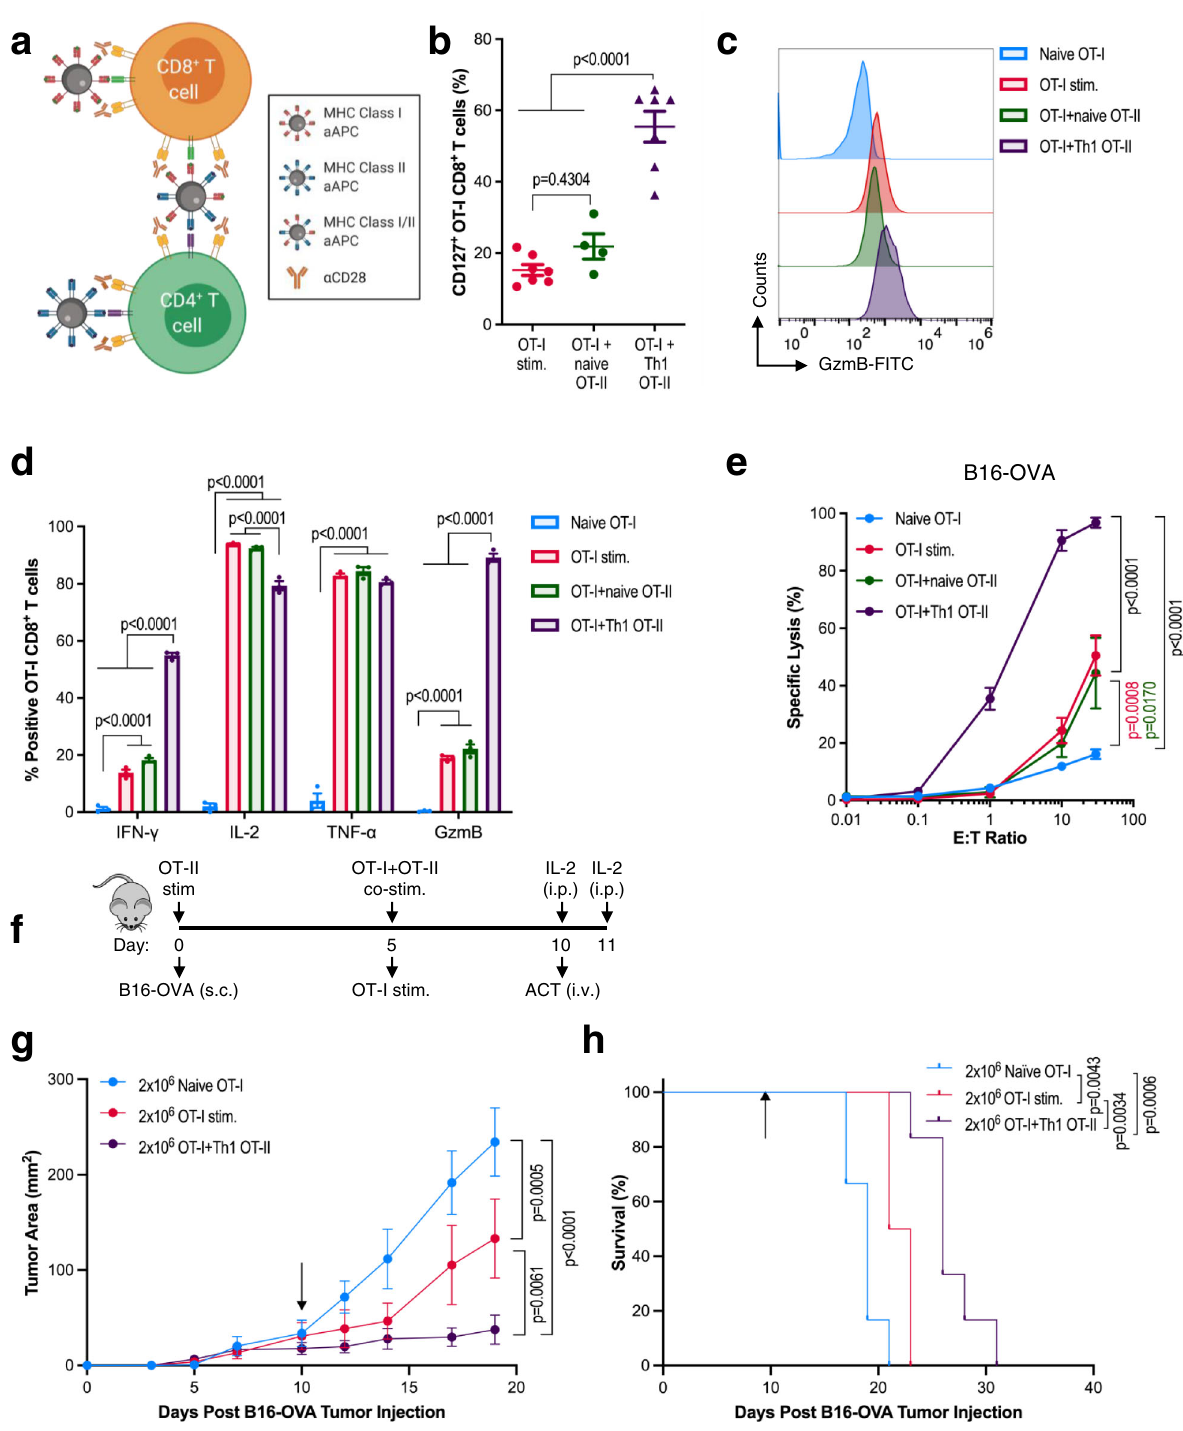
Fig.4|MHCIIaAPCsmodulateCD4 + Tcellhelperfunction.a Schematicshowing separate (I+II) or joint presentation (I/II) of MHC I and MHC II on aAPCs to CD4 + and CD8 + T cells to facilitate cell-cell crosstalk. Created with